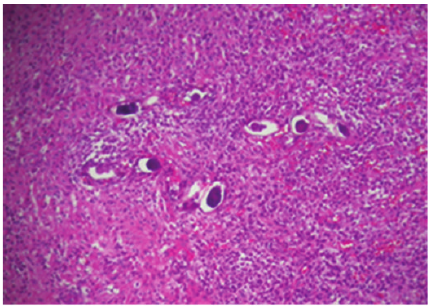
Figure 2: Histopathologically, ovarian parenchyma chronic inflam- mation involving numerous viable S. mansoni eggs often containing